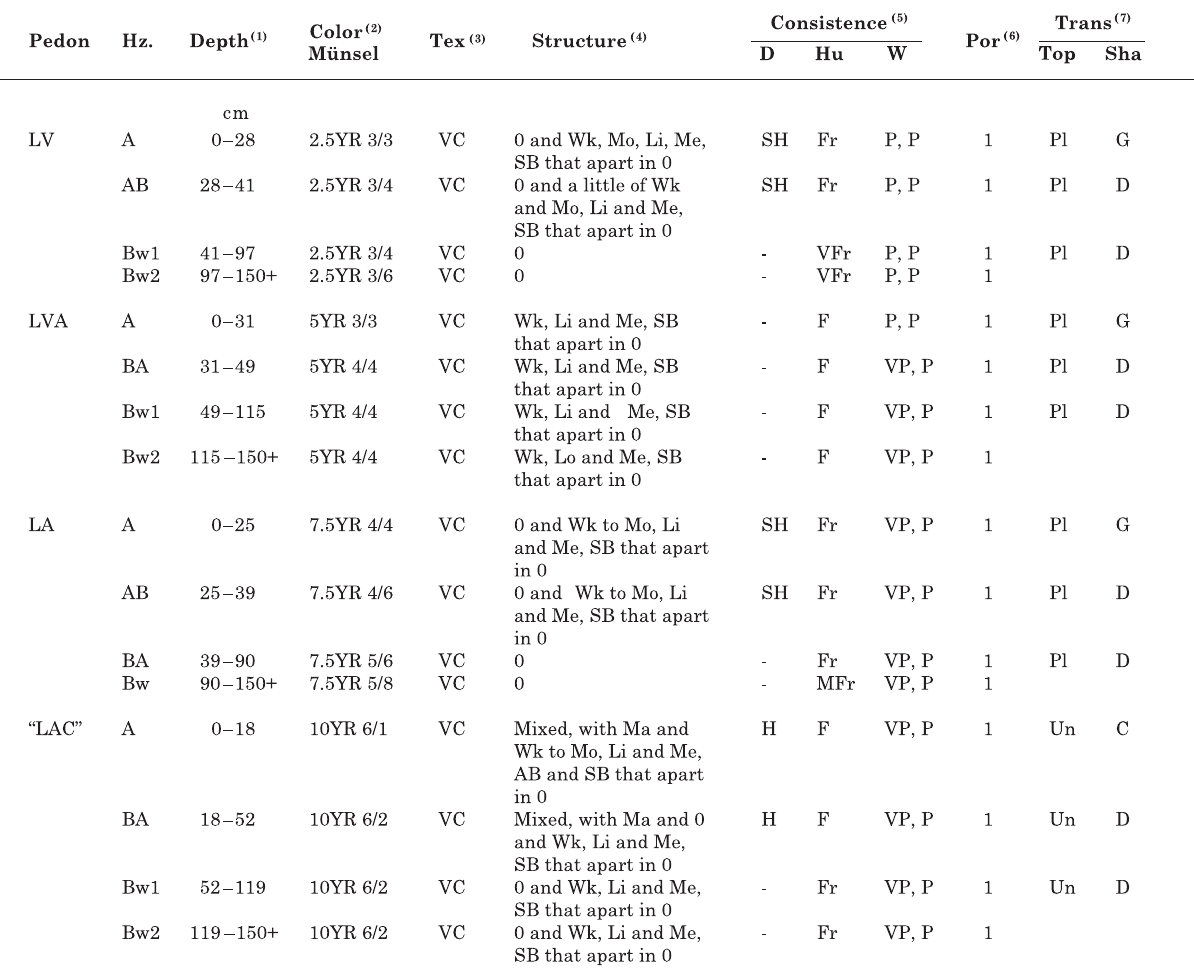
Table 1. Morphological properties of Oxisols in the toposequence